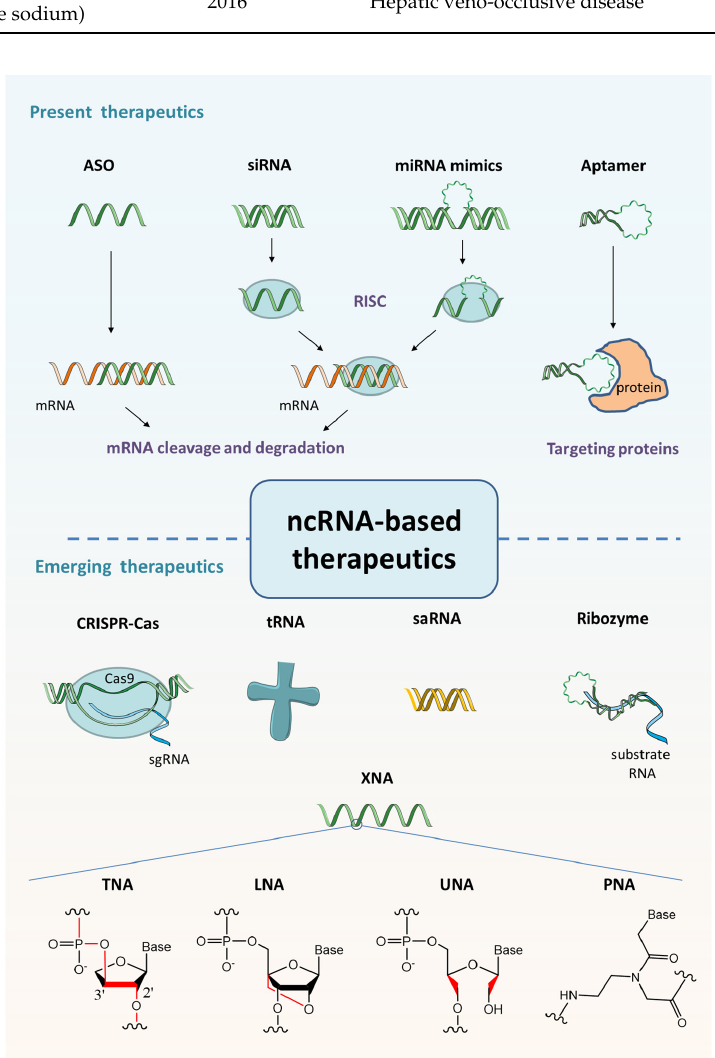
Figure 2. The structure and function of approved and emerging ncRNA-based nucleic acid drugs. ASOs are short, single-stranded RNA or DNA oligonucleotides that bind comple- mentarily to the target mRNA. ASO drugs usually follow three types of mechanisms: (1) recruiting RNase H and promoting degradation of mRNA, (2) sterically blocking the in- teraction between mRNA and ribosome, (3) alternative splicing of pre-mRNA in exon skipping or exon inclusion manner [40,41]. By now, nine ASO drugs have been approved for clinical applications, most of which target rare disease such as Duchenne Muscular Dystrophy (DMD). The high-throughput ASO screening platforms and AI technology promote the design of ASO sequences with high efficacy, low off-target toxicity and clear mode of action. The main concern of ASOs is how to maintain the structural integrity and enhance the absorption during the delivery [42]. Aptamers are single-strand oligonucleotides with tertiary structure that can bind and modulate specific proteins. The screening system known as systemic evolution of ligands by exponential enrichment (SELEX) is used to produce aptamers in vitro. Ap- tamers are called chemical antibodies because the synthetic molecules act similarly to antibodies [43]. Pegaptanib (Macugen) is a 28-nucleotides RNA aptamer targeting VEGF.